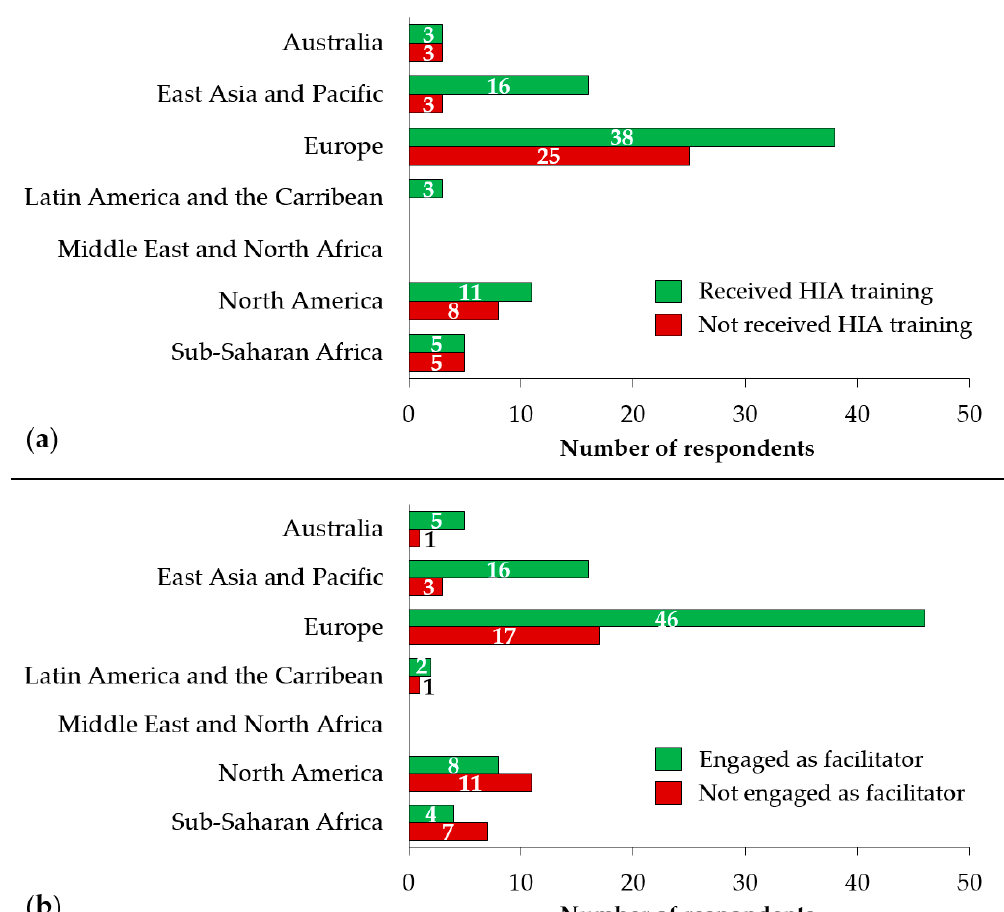
Figure 4. ( a ) HIA practitioners who have ever had an HIA training; and ( b ) were engaged as HIA training